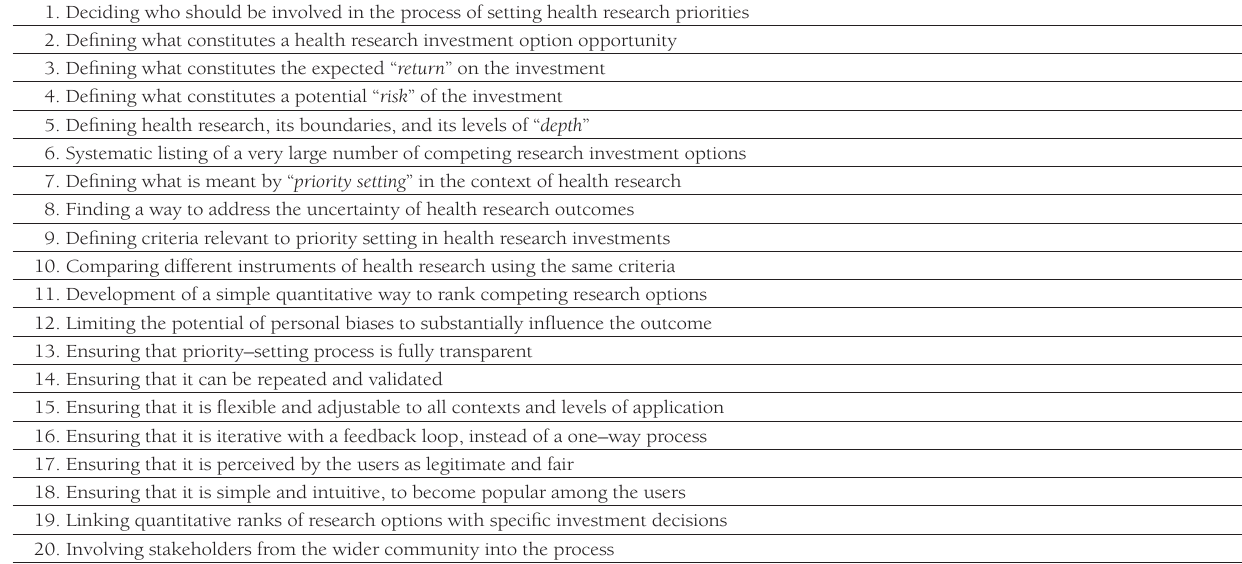
Table 1. A list of twenty “universal challenges” in setting priorities in health research investments, according to the CHNRI method's conceptual framework [ 5